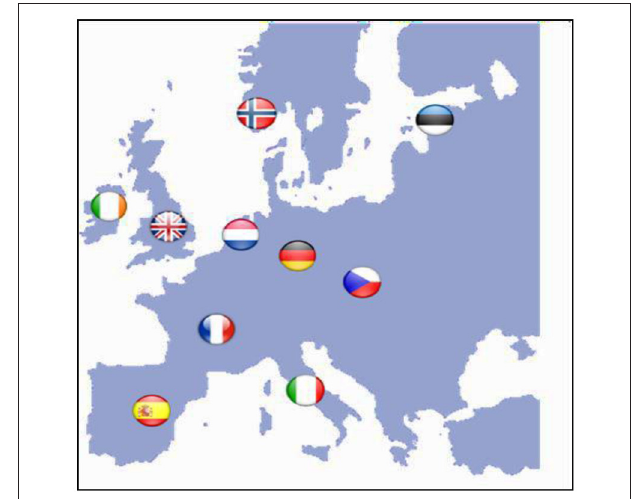
FIGURE 1 | The 10 countries surveyed in the CLAMER poll were Norway; Netherlands; United Kingdom; Germany; Estonia; France; Ireland; Czech Republic; Spain and Italy.